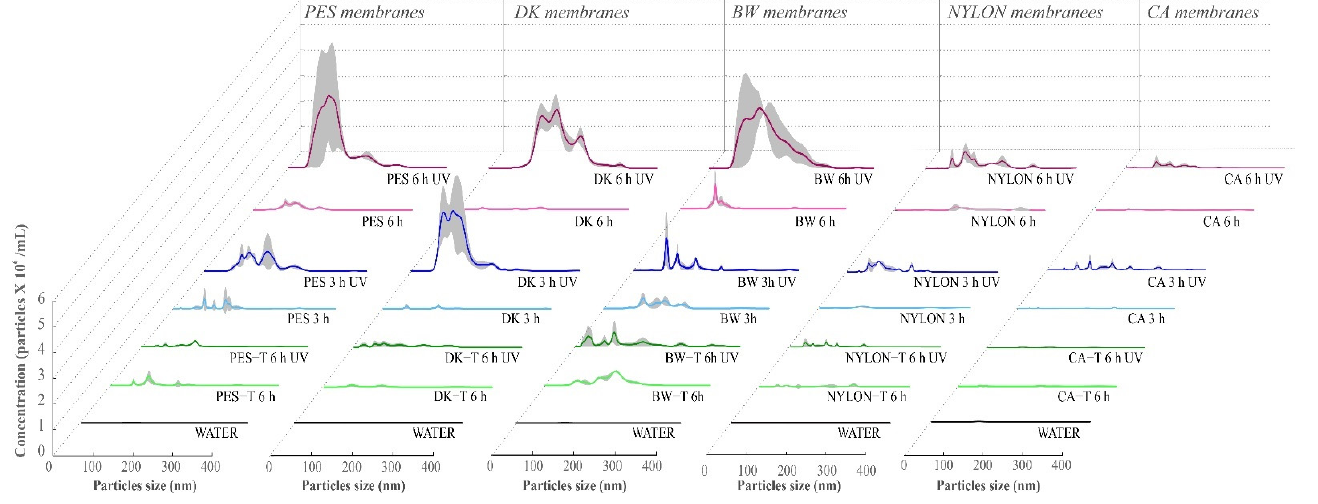
BW BW-T not analyzed